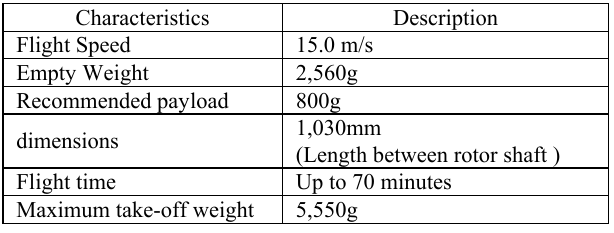
Table 2. Characteristics of MD4-1000